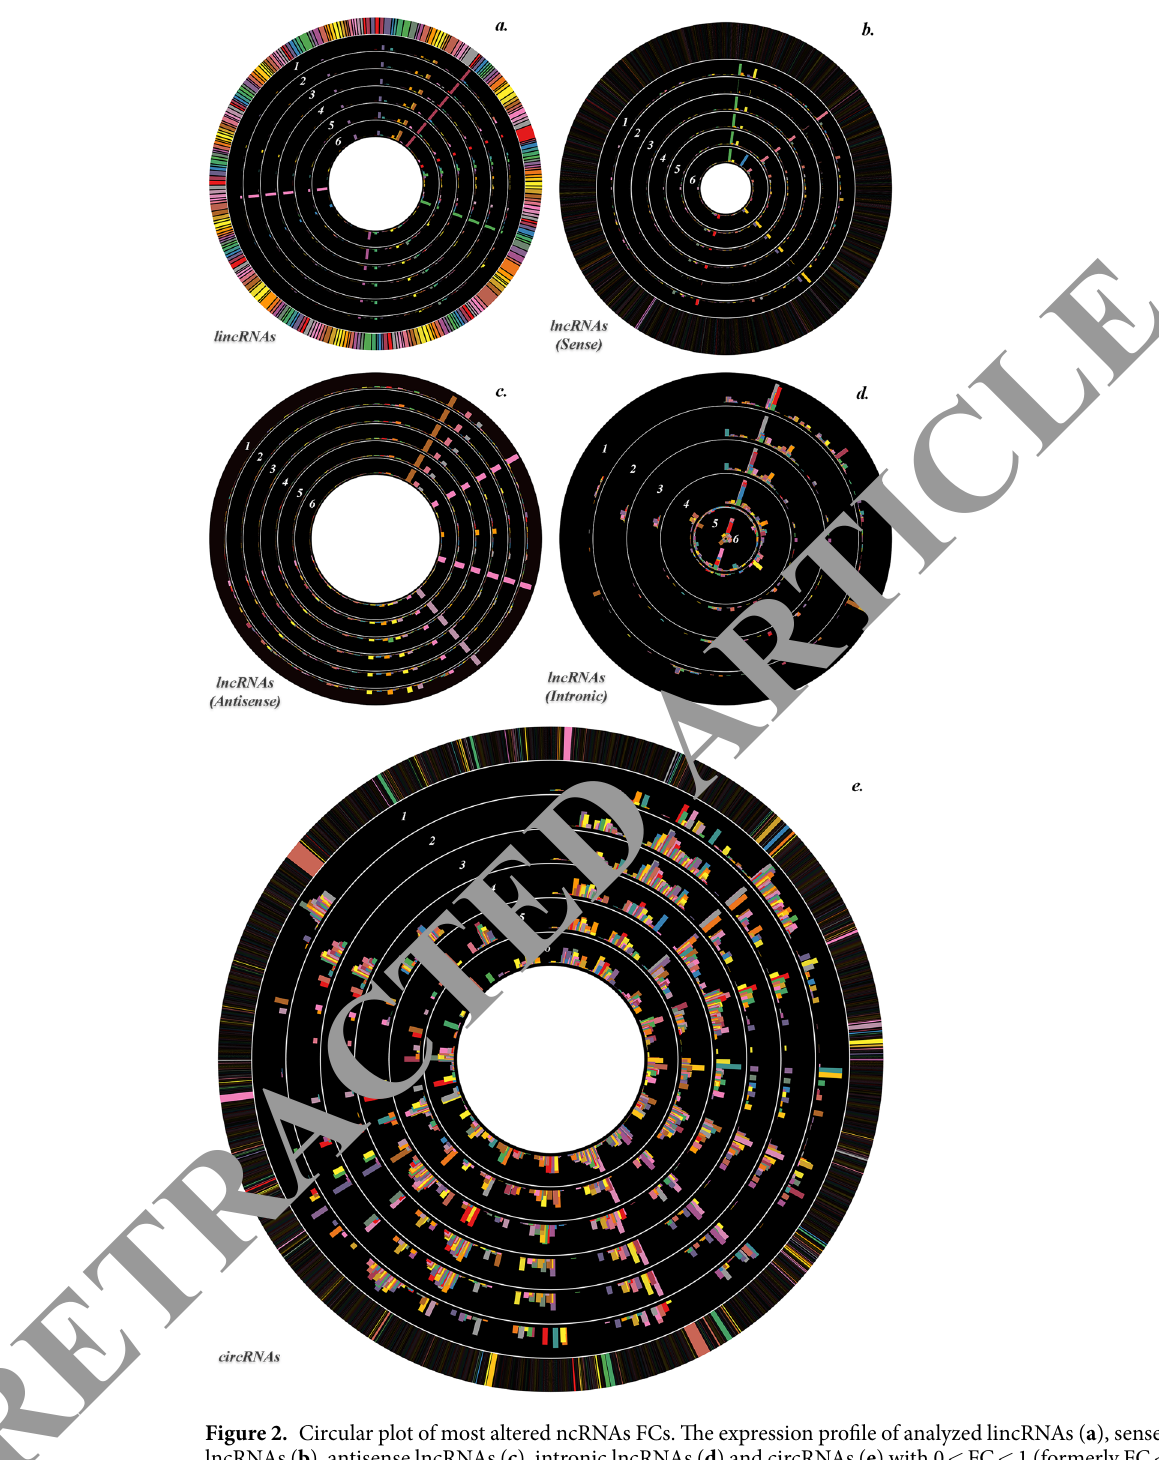
Figure 2. Circular plot of most altered ncRNAs FCs. The expression profile of analyzed lincRNAs ( a ), sense lncRNAs ( b ), antisense lncRNAs ( c ), intronic lncRNAs ( d ) and circRNAs ( e ) with 0 < FC < 1 (formerly FC < − 2 in the manuscript) or FC > + 2 between treated and untreated RPE samples was visualized in Circos. All FCs are log2 transformed. The expression profile of each considered time point is represented as a single circle, and FCs of the individual ncRNAs are proportional to histogram bar height. The time point–related order of the ncRNA expression profile samples is from the outer circle to the inside, as depicted by inserted numbers. 1. 0 h vs 1 h – Treated. 2. 0 h vs 1 h – Untreated. 3. 1 h (Treated vs Untreated). 4. 2 h (Treated vs Untreated). 5. 4 h (Treated vs Untreated). 6. 6 h (Treated vs Untreated). A clustering of several groups of ncRNAs which follow the same trend through all considered time points is